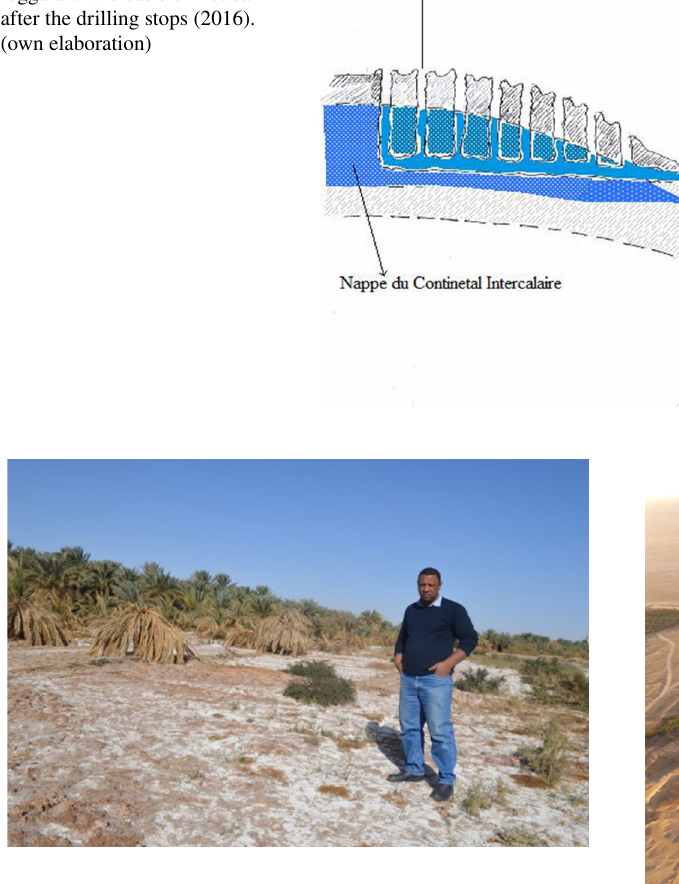
Fig. 10 Probable schema of a foggara of the oasis of Bouda after the drilling stops (2016).